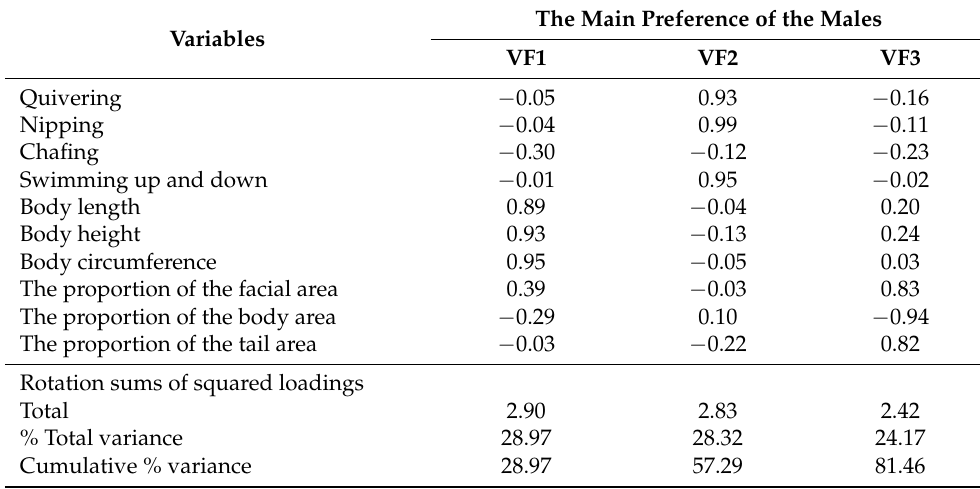
Table 3. The main preference features of males in mate choice in A. rivulatus .